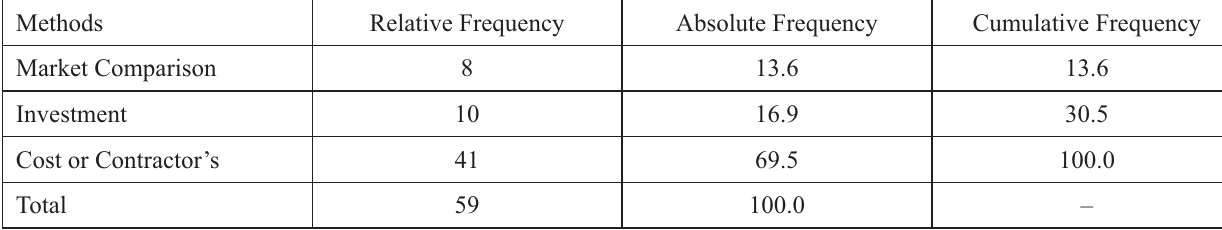
Table 4. Methods of Forced Sale Valuation